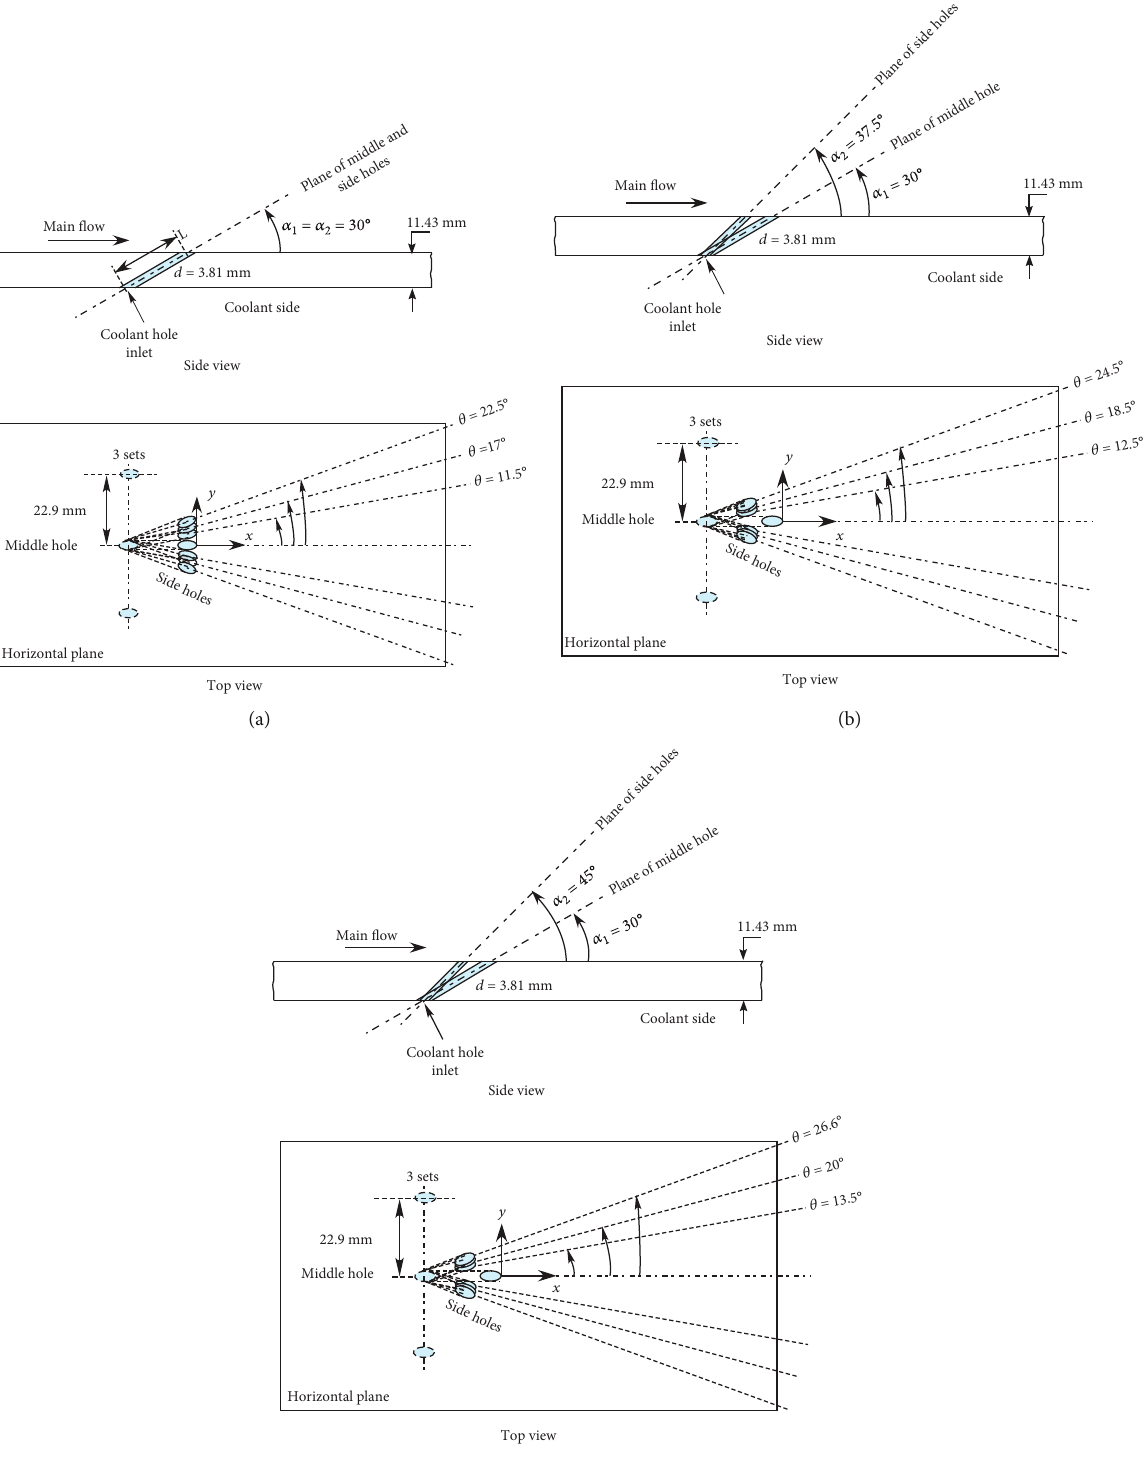
Figure 4: Details of the fi lm cooling hole geometries. (a) Case of the three holes with the same inclination angle of 30 ° . (b) Case of middle (primary) hole with an inclination angle of 30 ° and the two side holes with an inclination angle of 37.5 ° . (c) Case of middle (primary) hole with an inclination angle of 30 ° and the two side holes with an inclination angle of 45 °